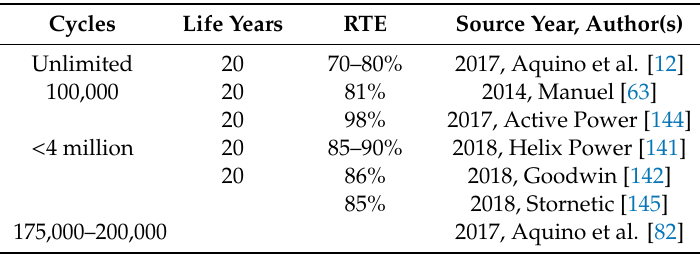
Table 29. Cycles, life years, and RTE—flywheel